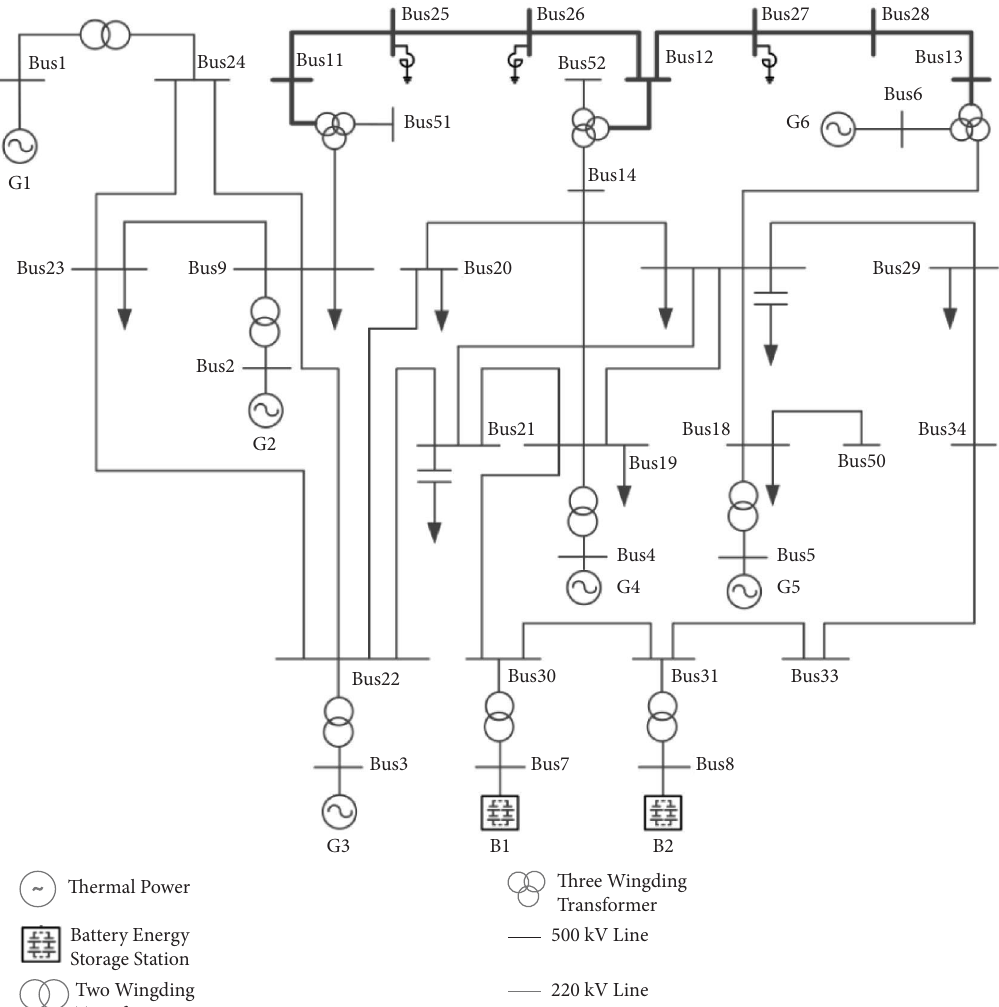
Figure 9: EPRI-36 node network wiring diagram including battery energy storage.